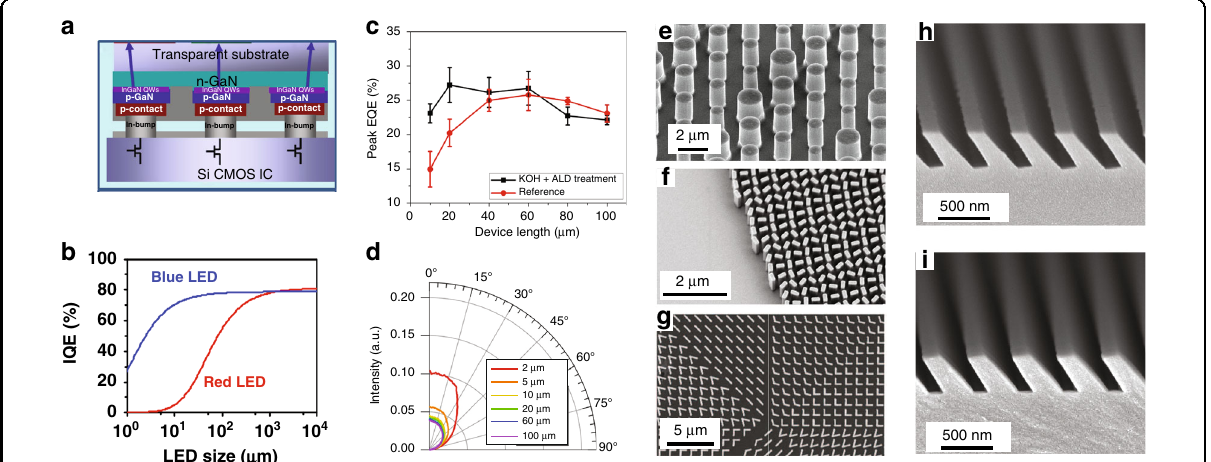
Fig. 4 Properties of lithography-enabled micro-LEDs and metasurfaces. a Illustration of fl ip-chip bonding technology. b Simulated IQE-LED size relations for red and blue LEDs based on ABC model. c Comparison of EQE of different LED sizes with and without KOH and ALD side wall treatment. d Angular emission pro fi les of LEDs with different sizes. Metasurfaces based on e resonance-tuning, f non-resonance tuning and g combination of both. h Replication master and i replicated SRG based on nanoimprint lithography. Reproduced from a ref. 55 with permission from AIP Publishing, b ref. 61 with permission from PNAS, c ref. 66 with permission from IOP Publishing, d ref. 67 with permission from AIP Publishing, e ref. 69 with permission from OSA Publishing f ref. 48 with permission from AAAS g ref. 70 with permission from AAAS and h , i ref. 85 with permission from OSA